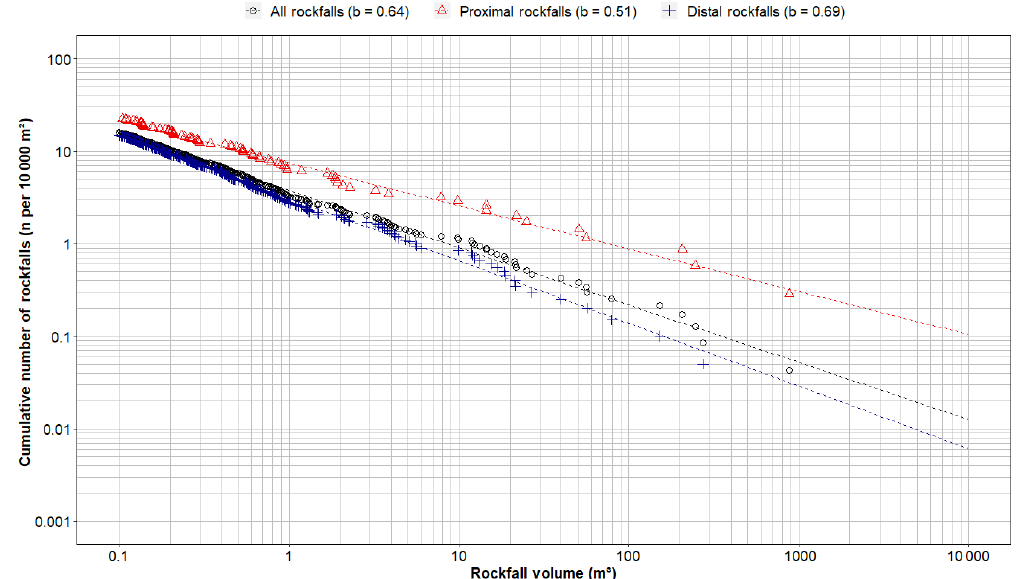
Figure 7. Magnitude–frequency distribution for all detected rockfalls, proximal rockfalls and distal rockfalls. The power-law exponent ( b ) de- termines the slope of the regression line (straight line in log–log space). Proximal rockfalls ( b = 0 . 51) are fitted by a flatter regression line than distal rockfalls ( b = 0 . 69), pointing to an increased frequency of large rockfalls in the vicinity of the glacier (i.e. in areas more recently exposed by glacier